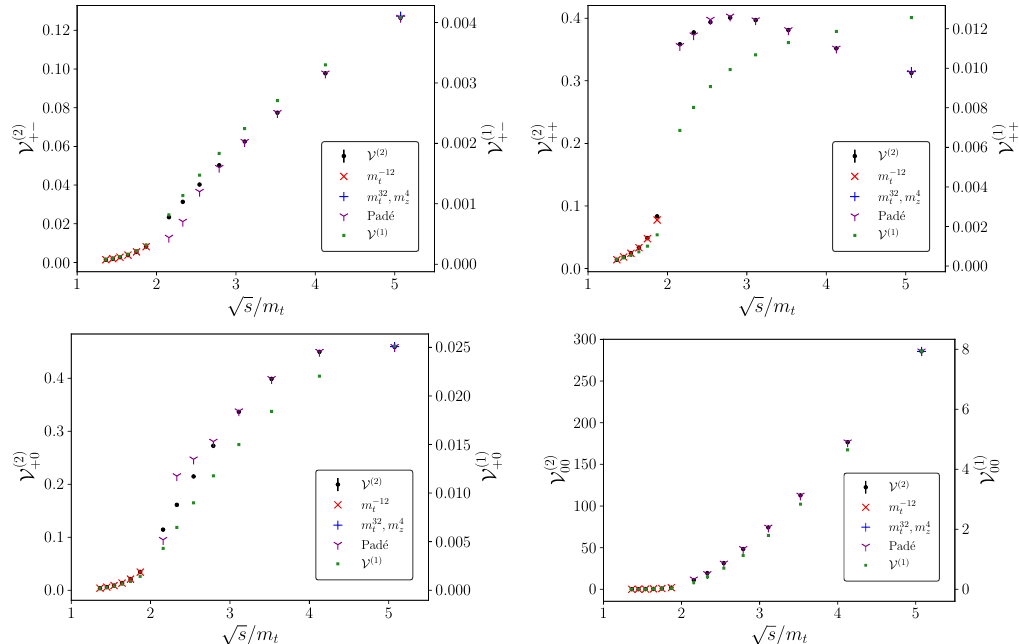
√ s = 247 GeV (Top Left Panel) and small √ s = 814 GeV (Bottom Panel).